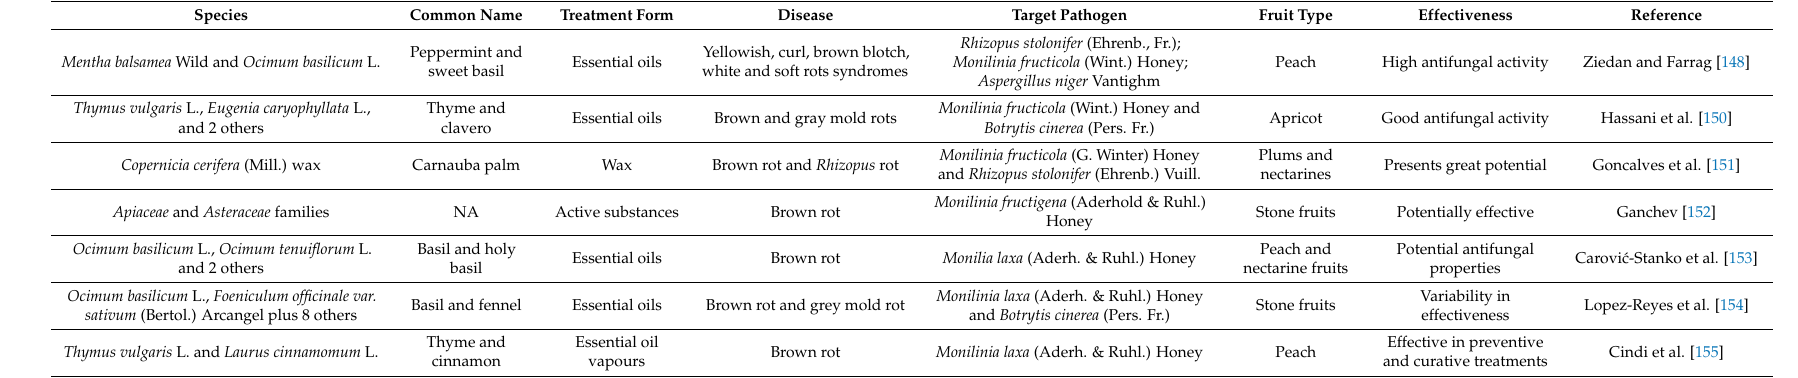
Table 5. Botanical products used on stone fruits in the postharvest control of brown